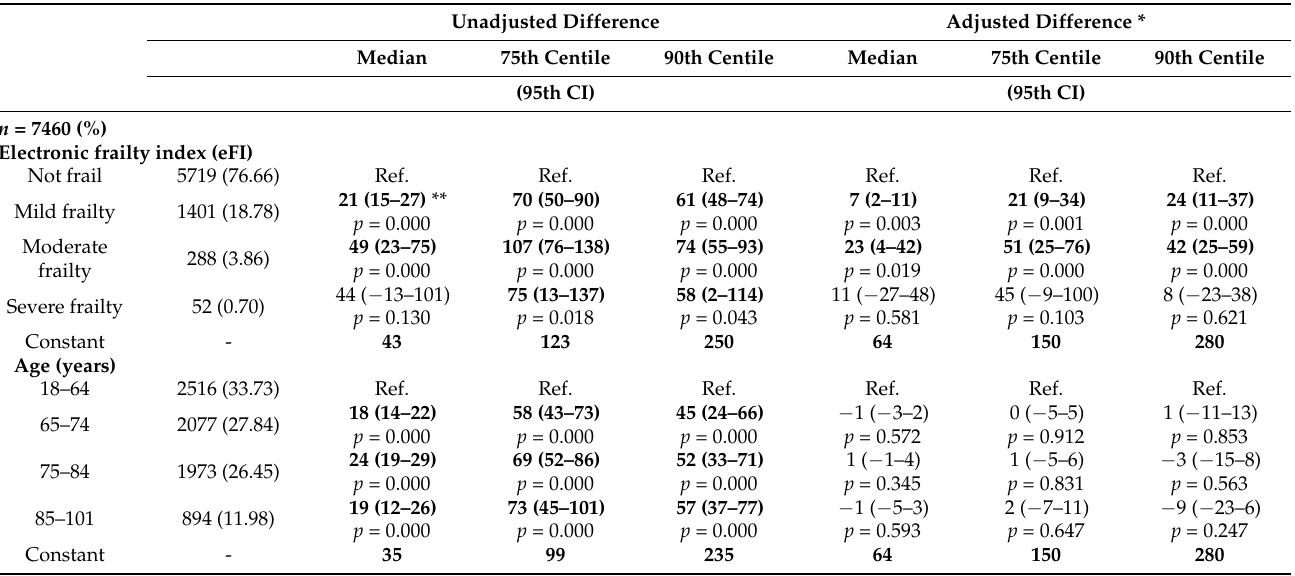
Table 2. Time to diagnosis (days) by frailty score and age category. Unadjusted